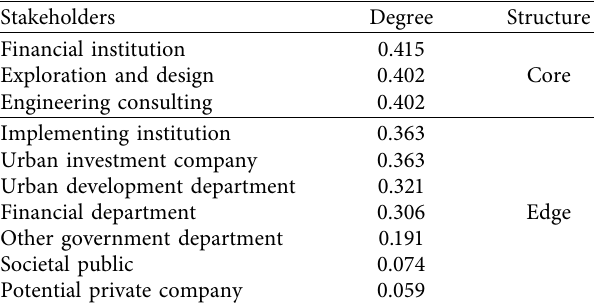
Table 6: Core-edge analysis of trust